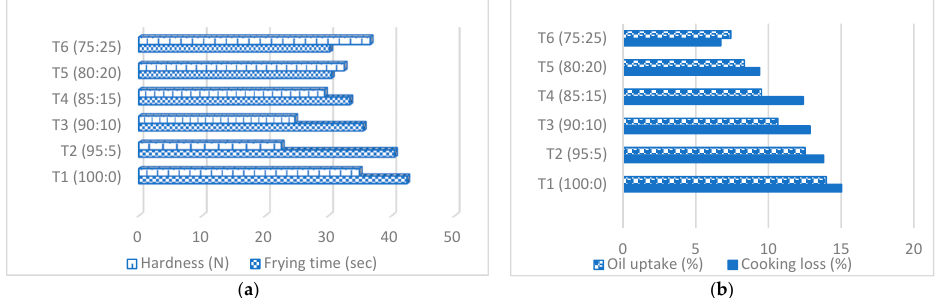
Figure 2. Color Scores of Ready-to-cook Gluten-free Snacks.